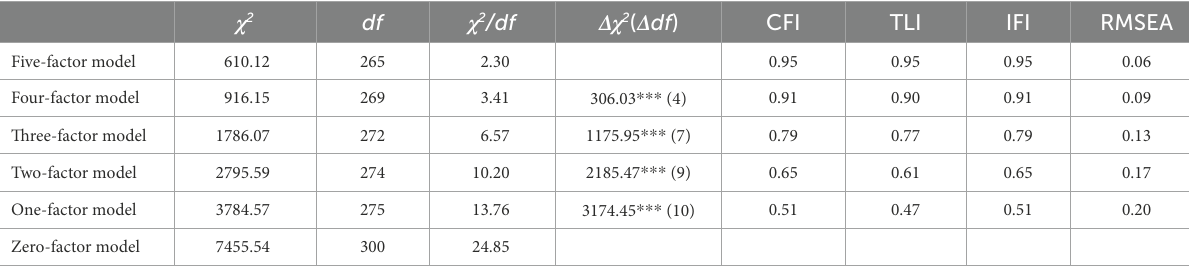
TABLE 1 Results of confirmatory factor